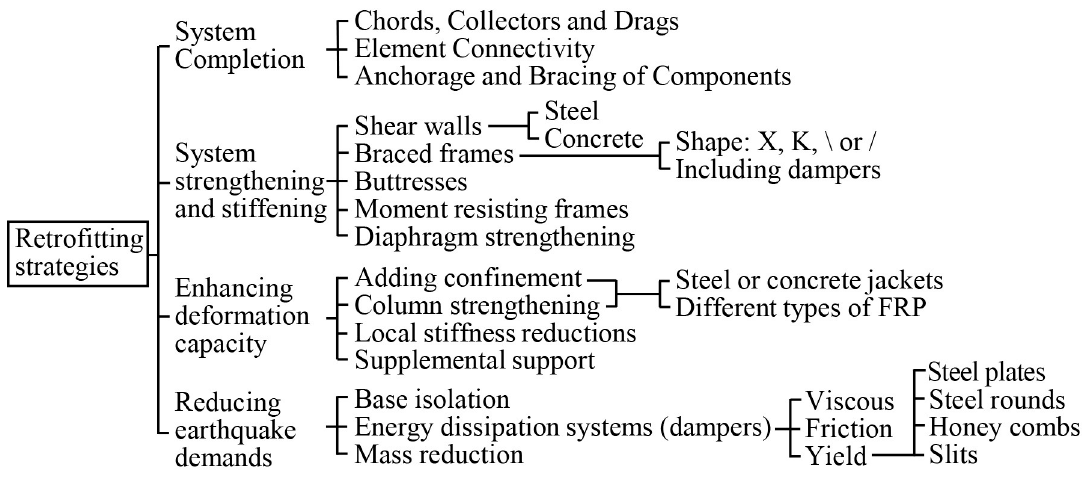
Fig 1. Retrofitting strategies published in the